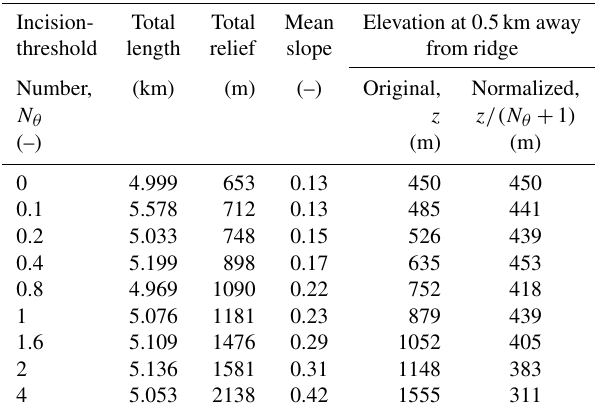
Table 5. Lengths, reliefs, and mean slopes of profiles along the longest flow paths of landscapes with different incision-threshold numbers N θ (see Table 4 and Sect. 3.2). These profiles are shown in Fig. 9 with their original elevations and in Fig. 10 with their ele- vations normalized by N θ + 1. To demonstrate that the dependence of elevations on N θ is reversed when profiles are normalized (see Sect. 3.2.2), we show in this table profile elevations at a distance of 0.5km from the